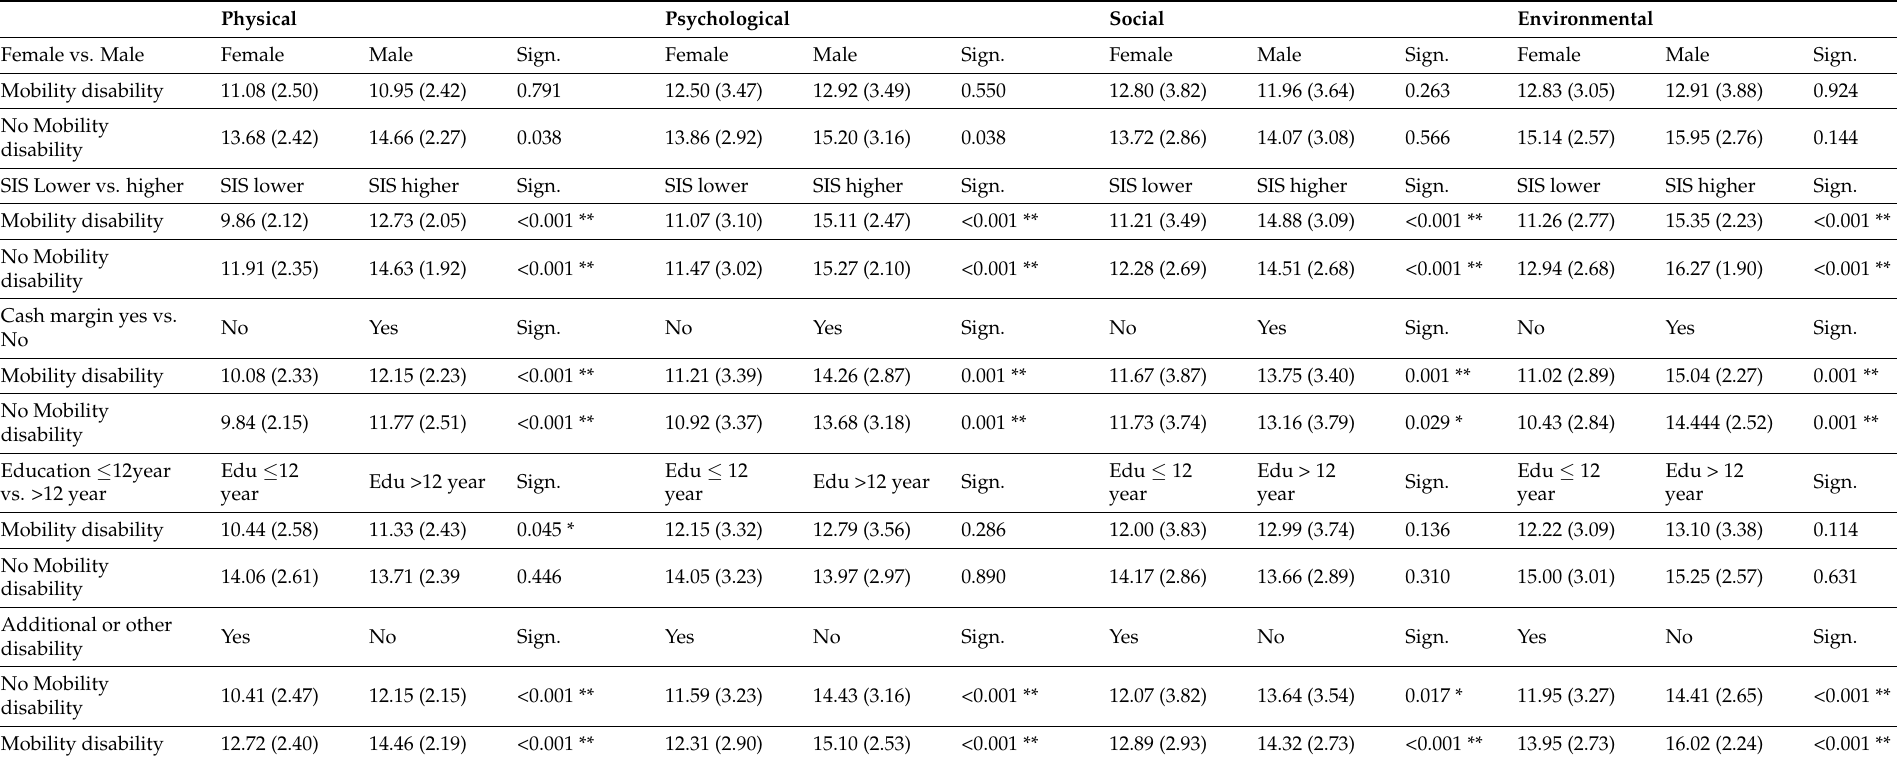
Table 5. Within-group associations for Sex, dichotomized SIS, cash margin, Education, other/additional disability WHOQOL-BREF domains, [mean (SD)] p -value for Welch t-test